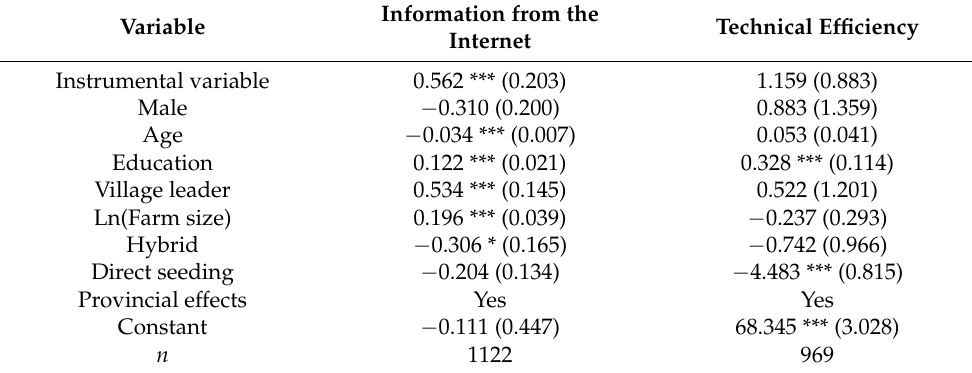
Table 6. Estimation results of falsification test on the instrumental